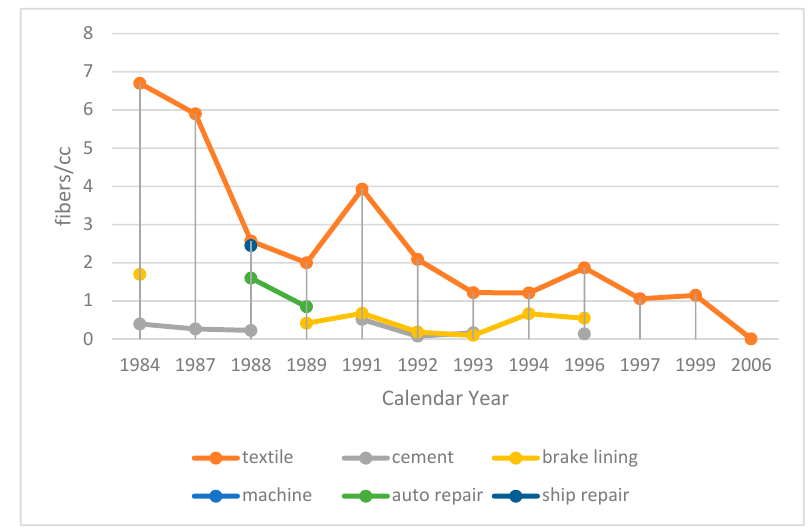
Figure 2. The level of asbestos air monitoring for different industries from 1984 to 2006.